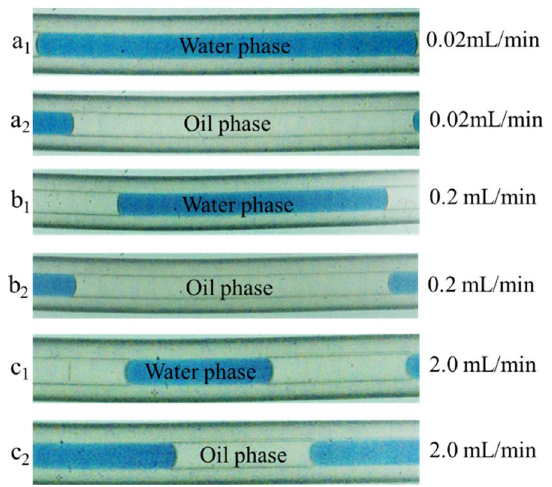
Figure 11. Images of toluene/water-phase slug flow formed in the capillary microreactor under different flow rates: 0.02 mL/min ( a 1 , a 2 ), 0.2 mL/min ( b 1 , b 2 ), and 2 mL/min ( c 1 , c 2 ).